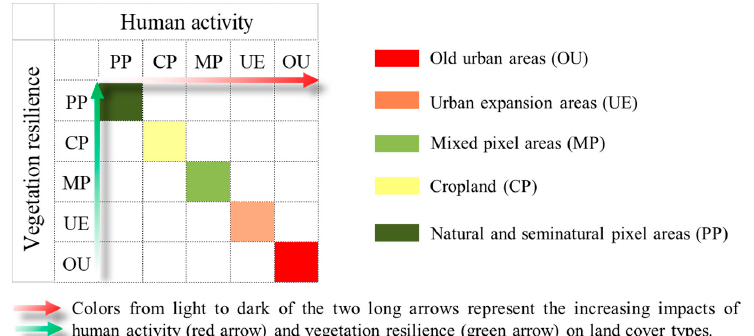
Figure 2. Land cover types that take into account human activity and vegetation resilience in Beijing. Pure pixels